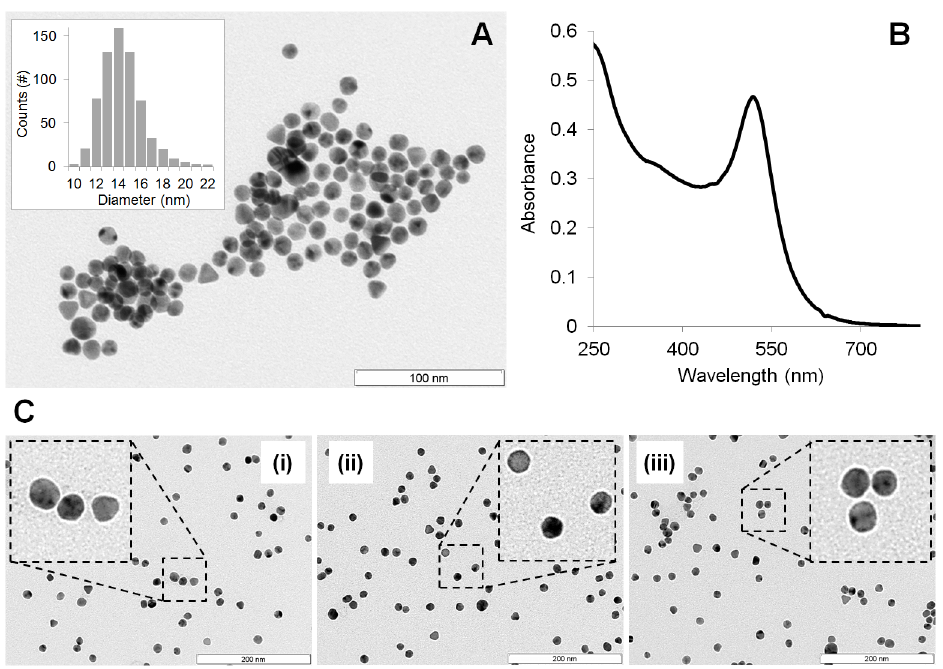
Fig 2. Gold nanoparticle characterisation. (A) TEM image of citrate-gold nanoparticles (scale bar = 100 nm). Inset: size distribution histogram showing an average diameter of 14.4 ± 2.0 nm. (B) UV-Vis spectra of the synthesized GNPs with the characteristic surface plasmon resonance (SPR) peak at 519 nm. (C) TEM image of antagomiR-gold nanoparticles (scale bar = 200 nm) (i) = NS (ii) = 5A (iii) =